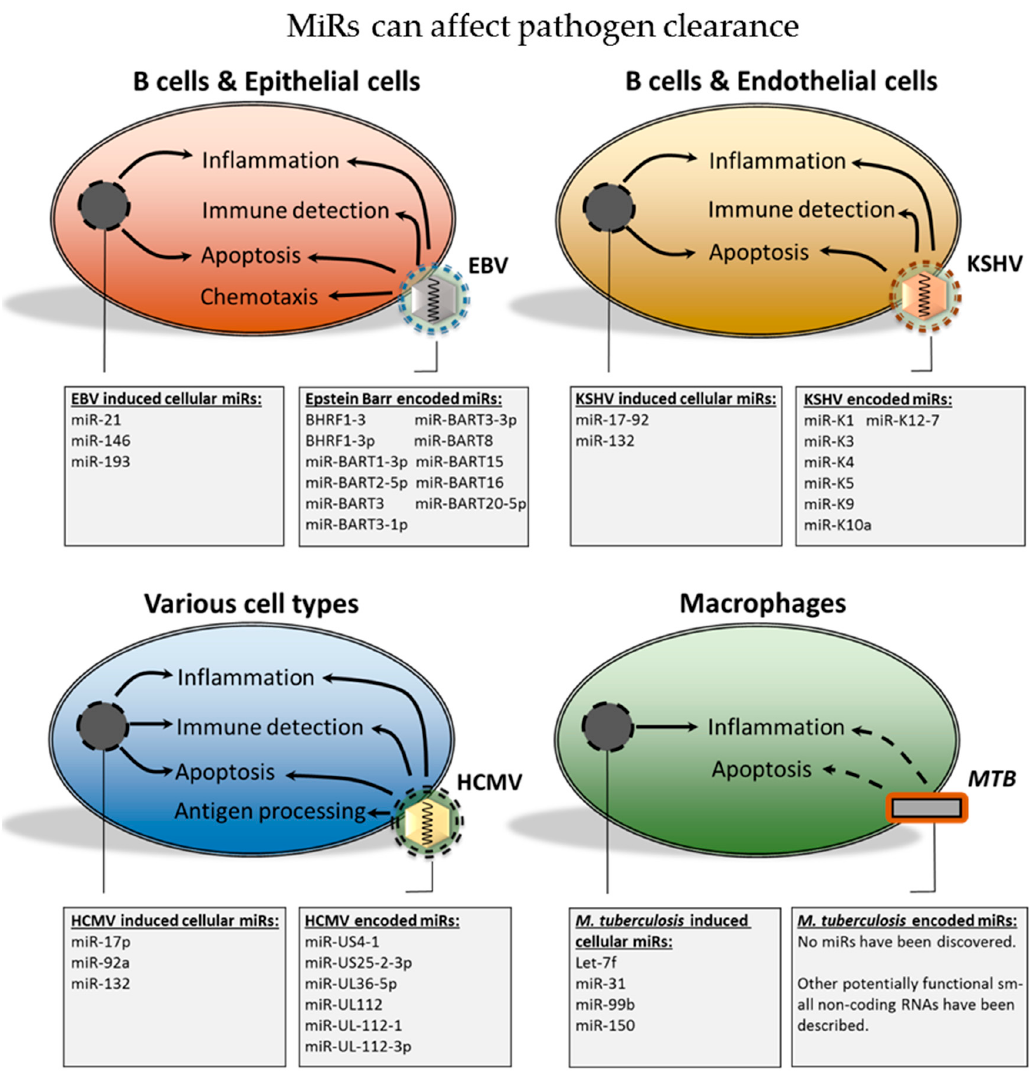
Figure 1. The herpesviridae have been shown to encode multiple miRs. The figure depicts the influence of these viral miRs on the immune response and viral clearance. Various analysis, including reporter assays and pull-down assays, have demonstrated that cellular mRNAs are targeted by viral miRs. This can result in decreased cellular mRNA transcription and translation of proteins, which are involved in antigen processing, inflammation, immune detection, chemotaxis and apoptosis. The figure also depicts the production of short non-coding RNAs by Mycobacterium tuberculosis (MTB), which may be relevant to its survival. Finally, host cell miRs may be induced by herpesviridae and MTB in order to shift the cellular miR expression profile and create a pathogen-permissive environment. EBV, Epstein-Barr virus; KSHV, Kaposi’s sarcoma-associated herpesvirus; HCMV, human cytomegalovirus.